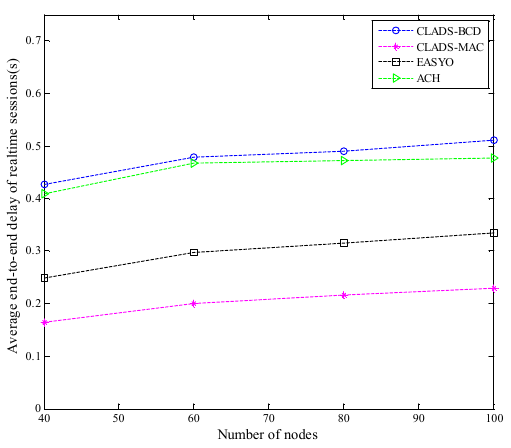
Figure 7. Average end-to-end delay of real-time sessions under different numbers of nodes.